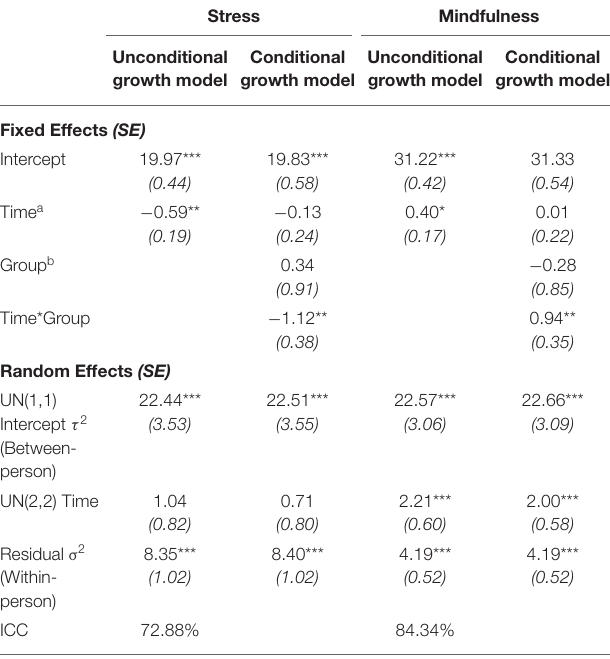
TABLE 3 | Parameter estimates for the growth curve models on outcomes of stress and mindfulness.